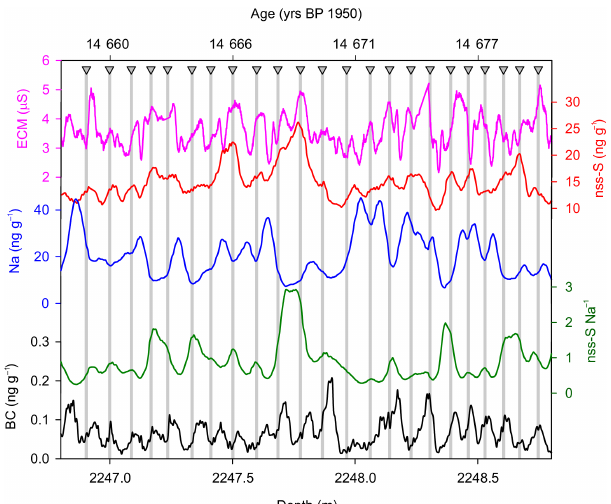
Figure 6. Example of a 2m long ice core section of WAIS Divide (approximately 14700 yearsBP) with annual-layer markers (trian- gles with grey lines) indicated. Similar to Fig. 5, annual layers are identified by matching pairs of winter, spring, and summer tracers. [Na] and [nss-S], determined by inductively coupled plasma mass spectrometry (ICPMS), do not always show clear annual cycles in this section with an average layer thickness of 8cma − 1 , thus lim- iting their use for annual-layer dating in the deeper part of WAIS Divide. Annual layers are identified here using the autumn maxima in [BC] and the summer maxima in the ECM